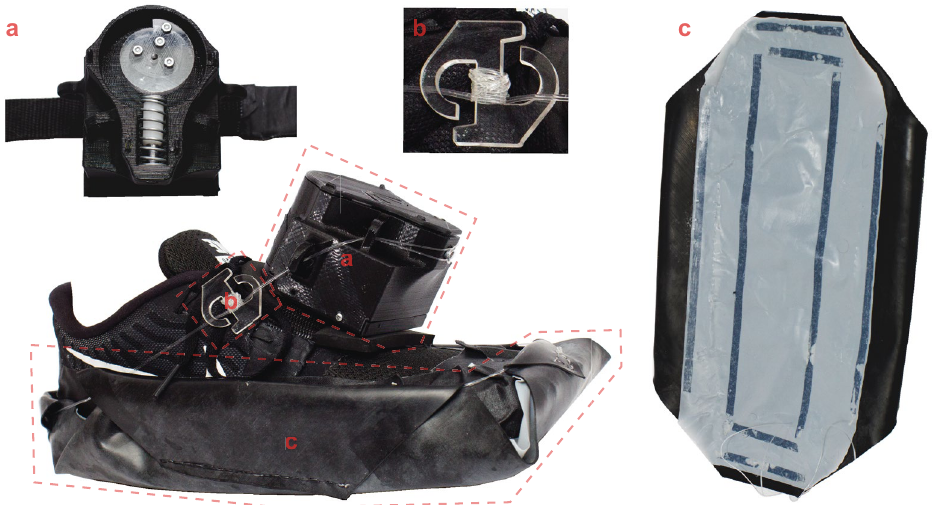
Figure 1. The Wearable Apparatus for Slip Perturbations (WASP) used in this study. This device consists of three components: ( a ) a wireless triggering mechanism consisting of a motorized cam-and-follower, ( b ) a tensioner that allows the device to fit securely to a range of shoe sizes, and ( c ) a flexible rubber outsole laminated with a polytetrafluoroethylene sheet that supplies both the friction with the ground to walk naturally in its attached state and the low-friction surface that participants are exposed to upon triggering. Lubricant was applied between the shoe and the outsole between each trial to further reduce friction upon outsole release.